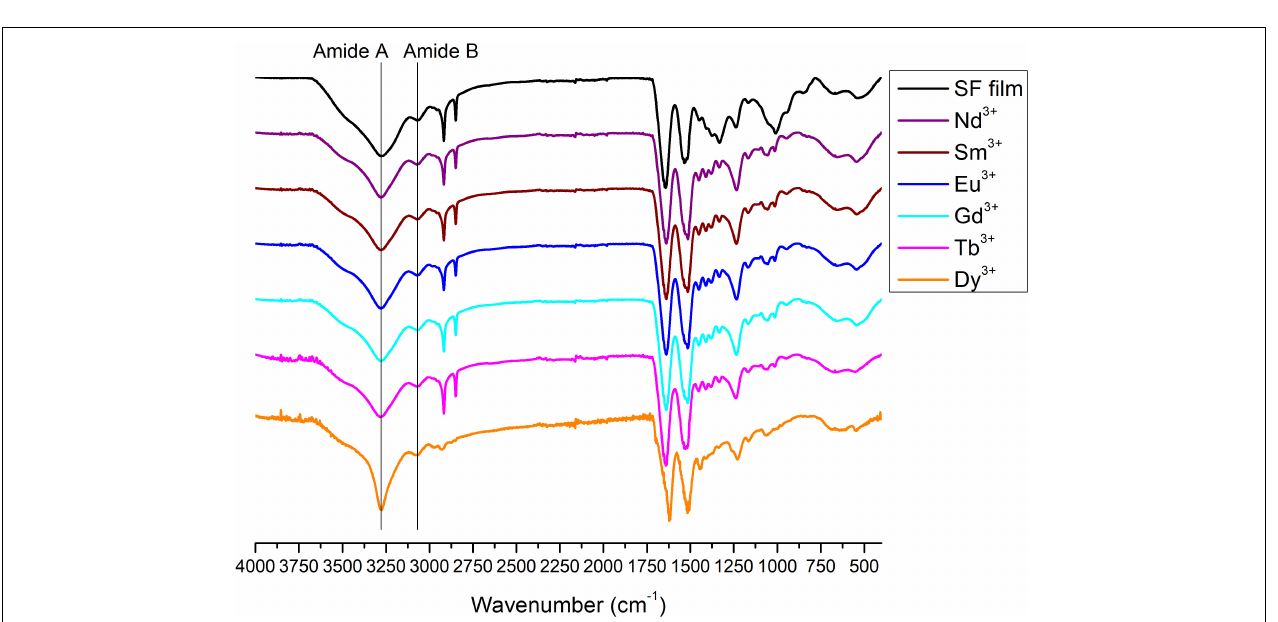
FIGURE 8 | Expansion of the amide band region, between 1750 and 900 cm − 1 , of the spectra in Figure 7 . Solid degummed SF (black curve) and regenerated solid Ln + 3 /SF (La + 3 /SF, Ce + 3 /SF, Pr + 3 /SF, Dy + 3 /SF, Er + 3 /SF, Tm + 3 /SF, Yb + 3 /SF, and Lu + 3 /SF).